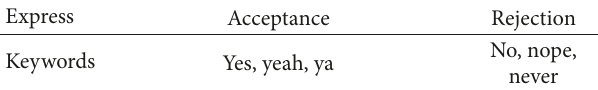
Table 3: Example of keywords to express acceptance and rejection.